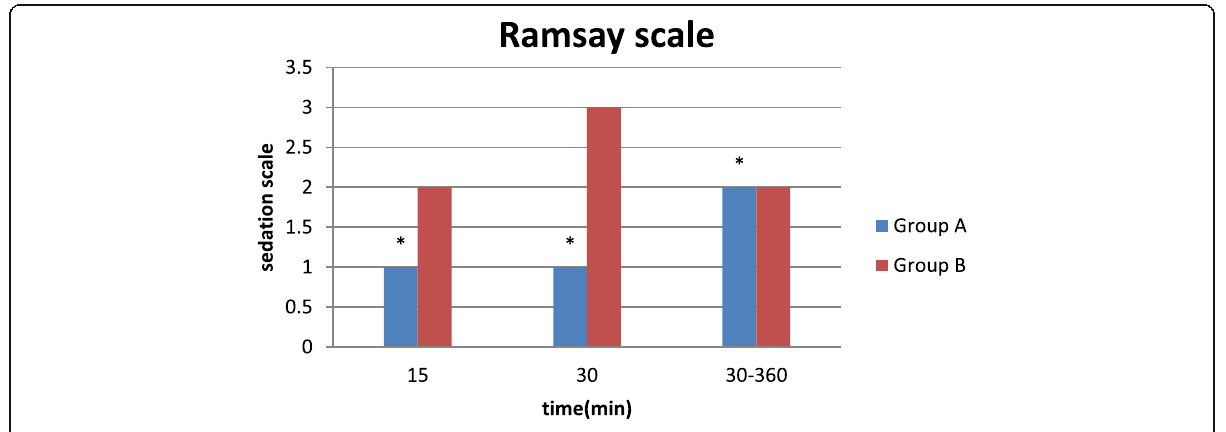
Fig. 3 Sedation score in both groups. Data were expressed as median. * P < 0.05